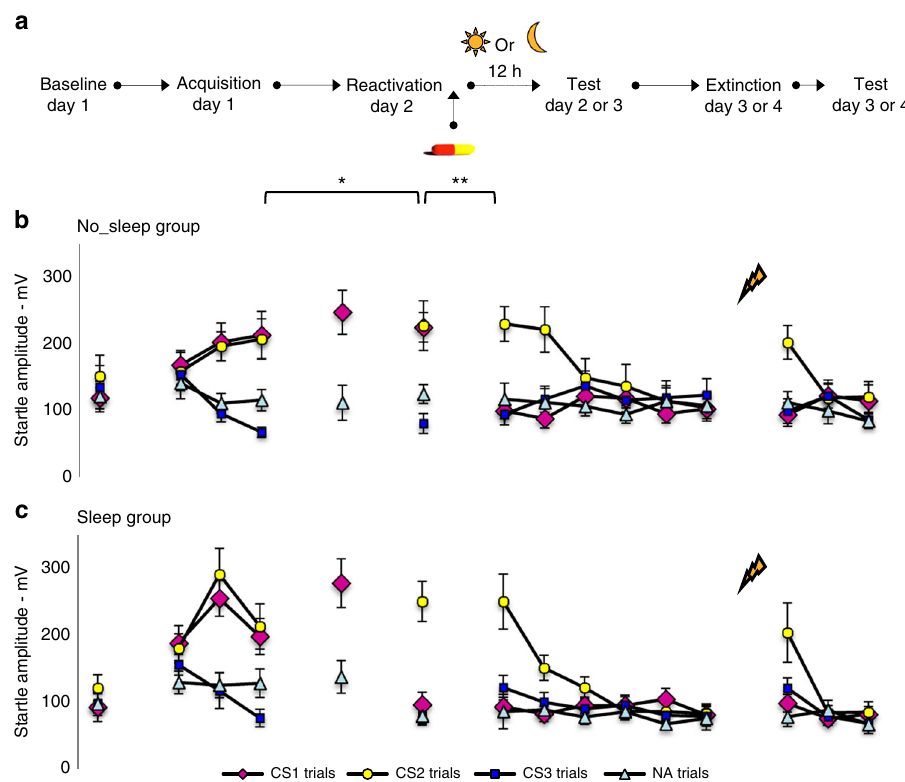
Fig. 3 Post-reactivation amnesia requires sleep. a Experimental design and timeline for the no_sleep and sleep groups. b Mean startle potentiation to the fear conditioned stimulus (CS1 — pink diamonds; CS2 — yellow dots), the control stimulus (CS3 — blue squares), and the noise alone (NA — gray triangles) trials during acquisition as well as reactivation and test for the no_sleep group and c the sleep group. Error bars represent s.e.m. * P < 0.05, ** P < 0.01, *** P < 0.001, within-between repeated measures